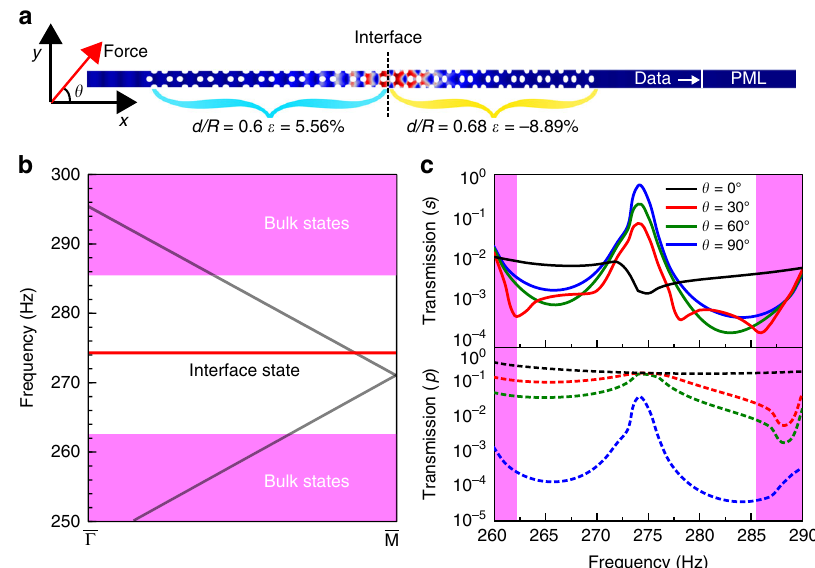
Fig. 3 Numerical observation of topological interface states. a The numerical calculation uses a ribbon with periodic boundary condition, consisting with two elastic metamaterials, (0.6, 5.56%|0.68, − 8.89%). The harmonic force with tunable angles is applied on the edge of the ribbon. b The simulated projected band structure along k x direction indicated by Γ M with transverse interface modes. The bars above Г and M are used to distinguish the Γ and M from band structure of unit cell. Red line indicates interface state independent of bulk state (magenta region) and gray lines indicate longitudinal wave modes. c The simulated transmission spectra as a function of excitation angle ( θ = 0°, 30°, 60°, and 90°). The transmission spectra for transverse modes (marked by s ) and longitudinal modes (marked by p ) are presented for